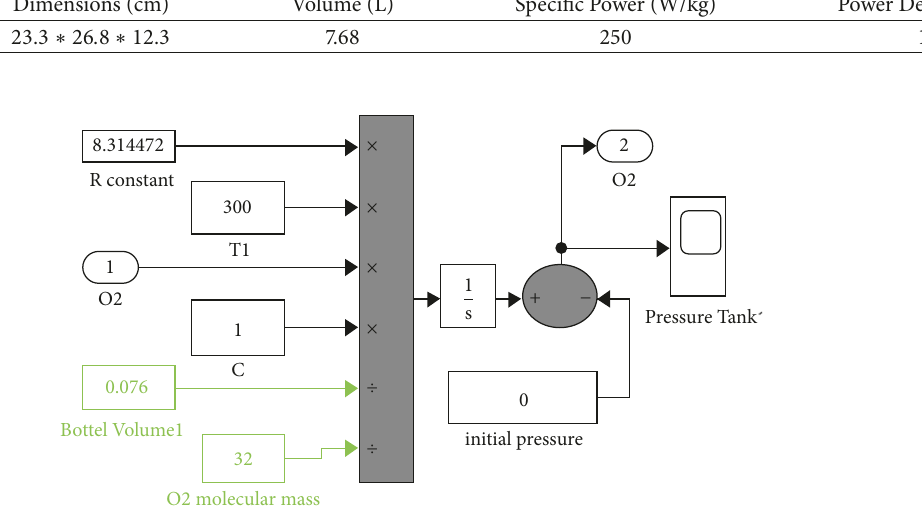
Figure 8: Oxygen tank in MATLAB/Simulink [12, 13].